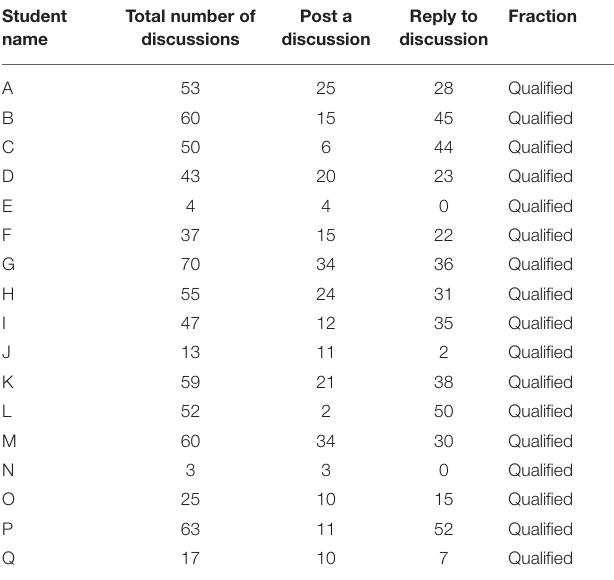
TABLE 5 | Student course